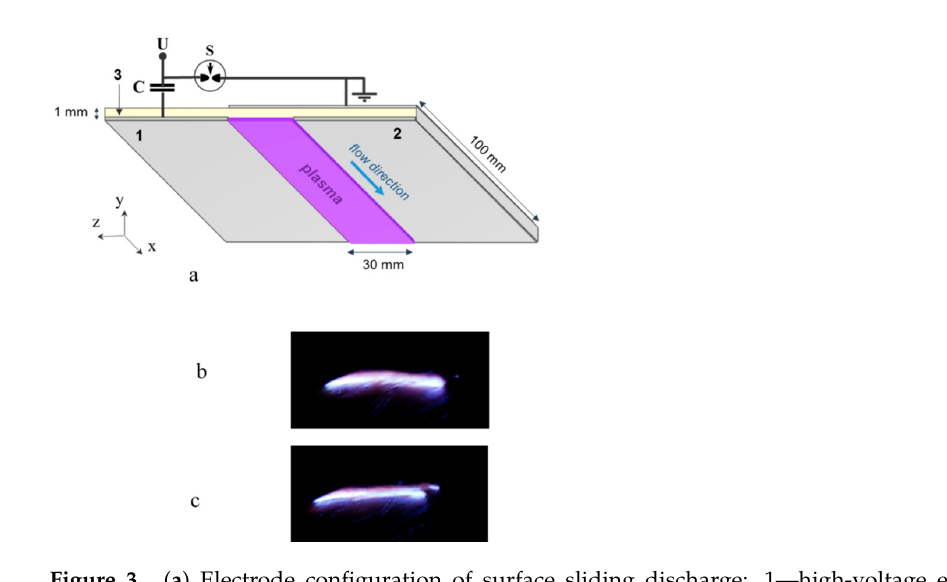
Figure 3. ( a ) Electrode configuration of surface sliding discharge: 1—high-voltage electrode; 2—grounded electrode; 3—dielectric; C—capacitor; S—spark gap; U—high voltage; photo images of discharge in supersonic air flow with inclined shock wave ( b , c ) at flow Mach number 1.33 ( b ) and 1.55 ( c ). Air density is 0.10 kg/m 3 .